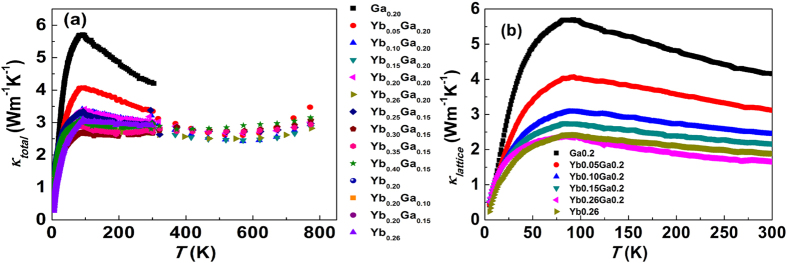
Thermal conductivity as a function of temperature.(a) Total thermal conductivity of all the samples and (b) lattice thermal conductivity of YbxGa0.2Co4Sb11.9333 (x = 0, 0.05, 0.10, 0.15, 0.26) and Yb0.26Co4Sb12.